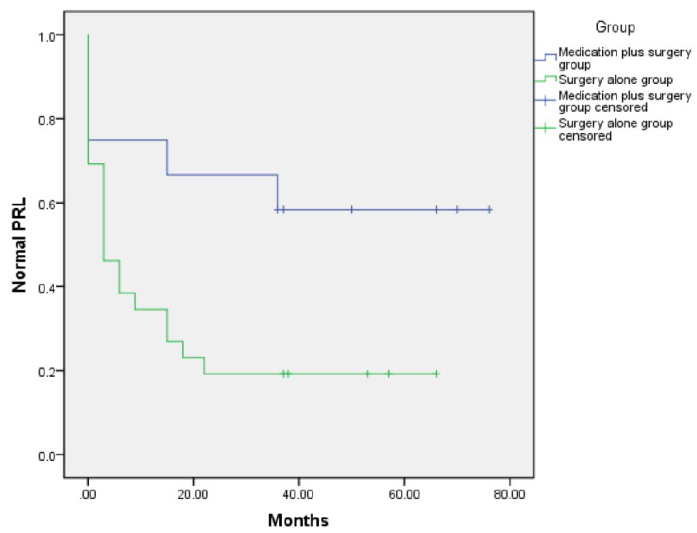
Figure 1. Kaplan–Meier analysis of postoperative time required for PRL level to return to normal in 38 patients with cystic pituitary prolactin-secreting macroadenomas, according to the different treatment plan. They were divided into the medication plus surgery and surgery alone